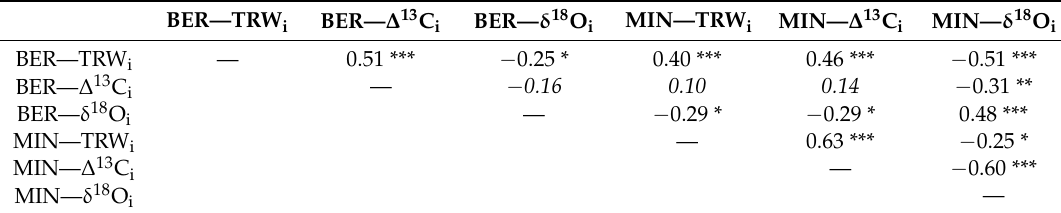
Table 2. Pearson correlations involving indexed tree-ring traits (TRW i , ∆ 13 C i and δ 18 O i ) within and between sites for the period 1940–2014. Site codes are as in Table 1. *, p < 0.05; **, p < 0.01; ***, p < 0.001 (non-significant correlation coefficients are indicated in